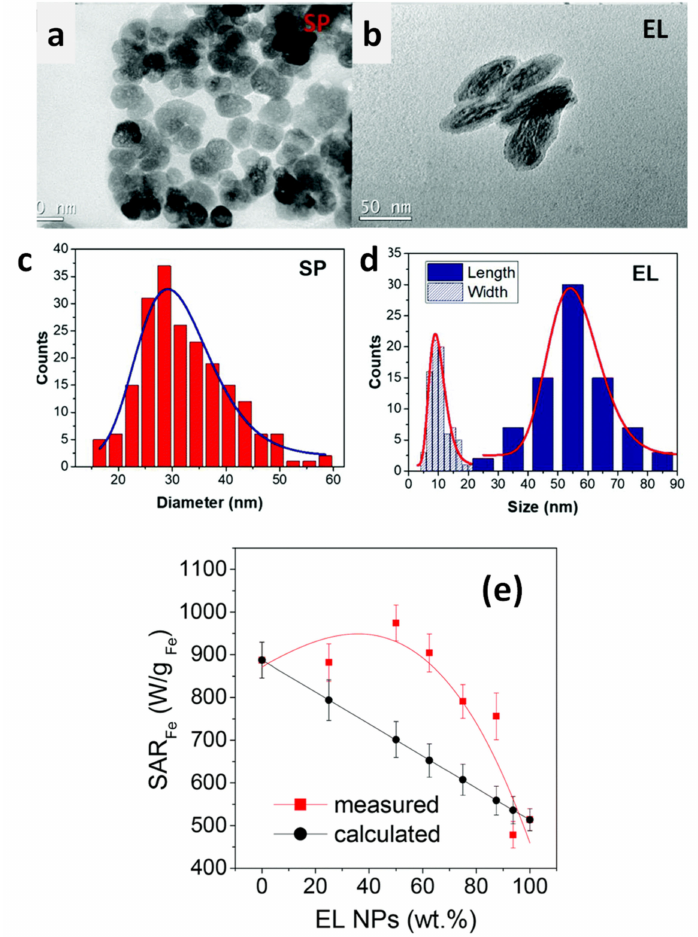
Figure 13. TEM images of ( a ) spherical NPs (SP) and ( b ) silica-coated elongated NPs (EL). Distribu- tions obtained from TEM images of: ( c ) SP diameter, ( d ) length and width of the magnetic core of EL NPs. ( e ) Measured and calculated SAR values for samples obtained by mixing the SP and EL NPs in different proportions (AMF of 48 kA/m and 96 kHz). The values are shown as functions of the fraction of EL NPs in the samples. The calculated values were obtained as the weighted sum of those of the parent SP end EL NPs. Adapted from Ref. [263] under CC BY_NC 3.0